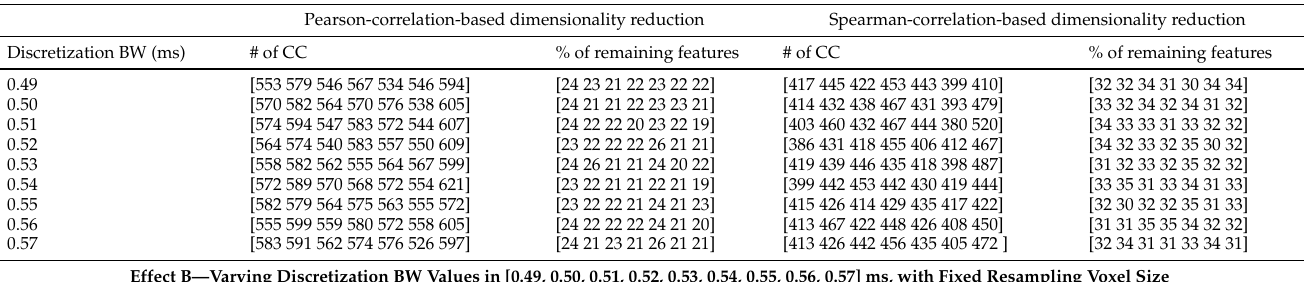
Table 4. Collinearity analysis and correlation-based dimensionality reduction for T2 maps. In the column “# of CC”, the number of pair-wise correlation coefficients that were significant and, in absolute value, greater than the predefined threshold is reported (see Section 2.5 for details). In the column “% of remaining features”, the percentage of remaining features after the correlation-based dimensionality reduction is reported.